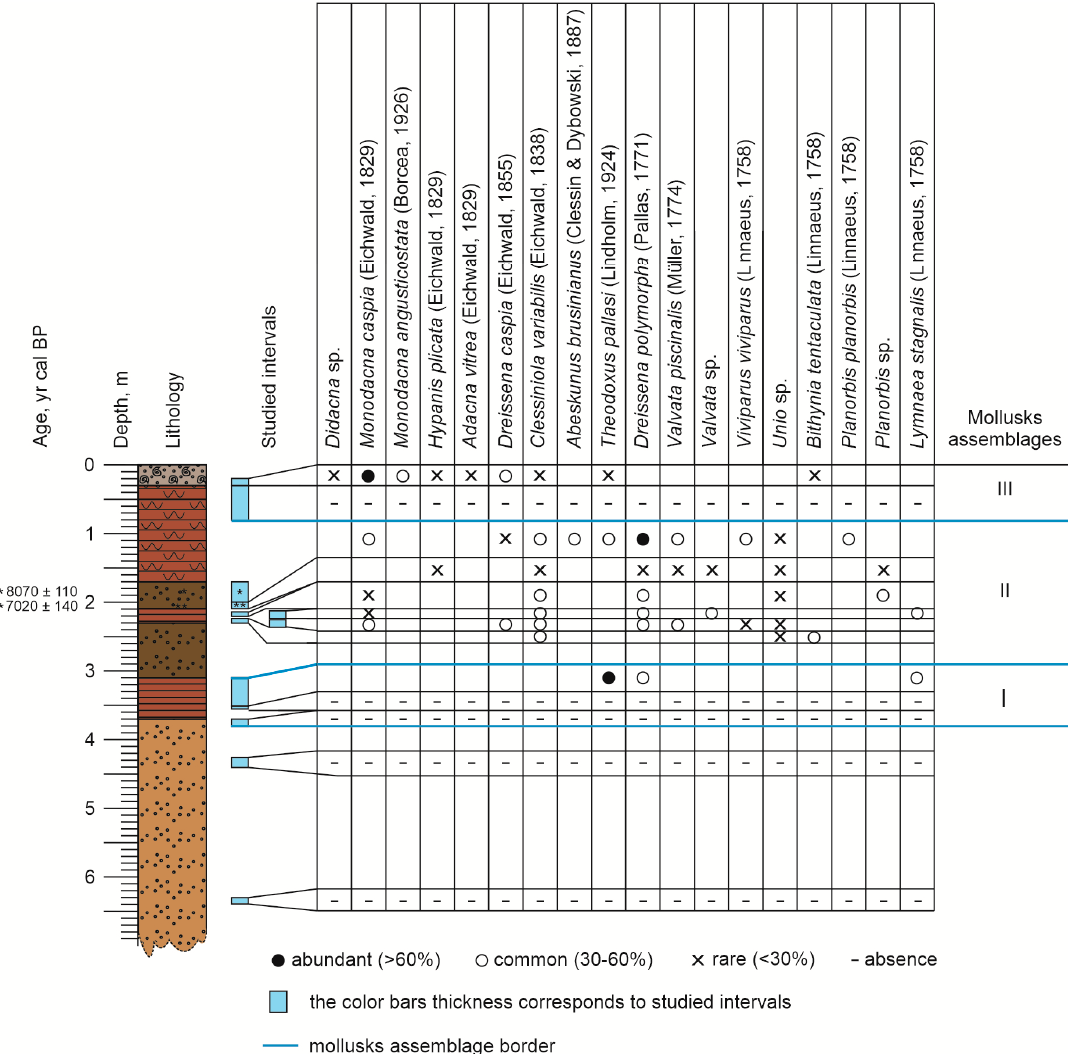
Figure 4. Rybachya core list of mollusks (grouped from left to right from marine/brackish water to freshwater species).